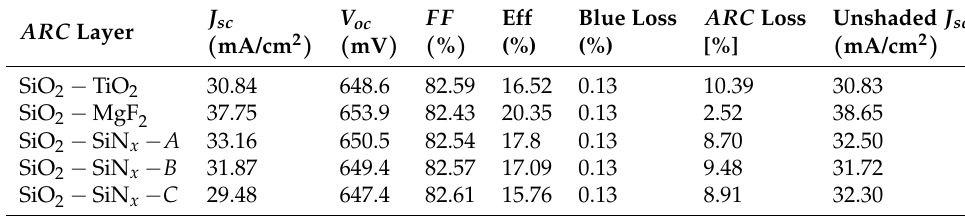
Table 2. I − V parameters of the different DLARC